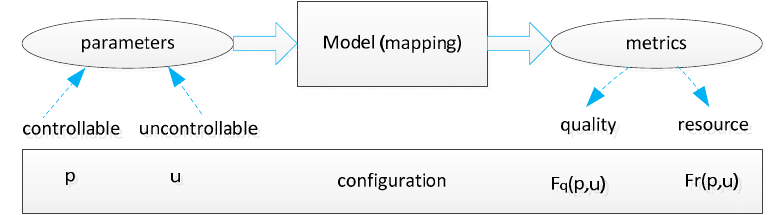
Figure 13. The basic mapping model.